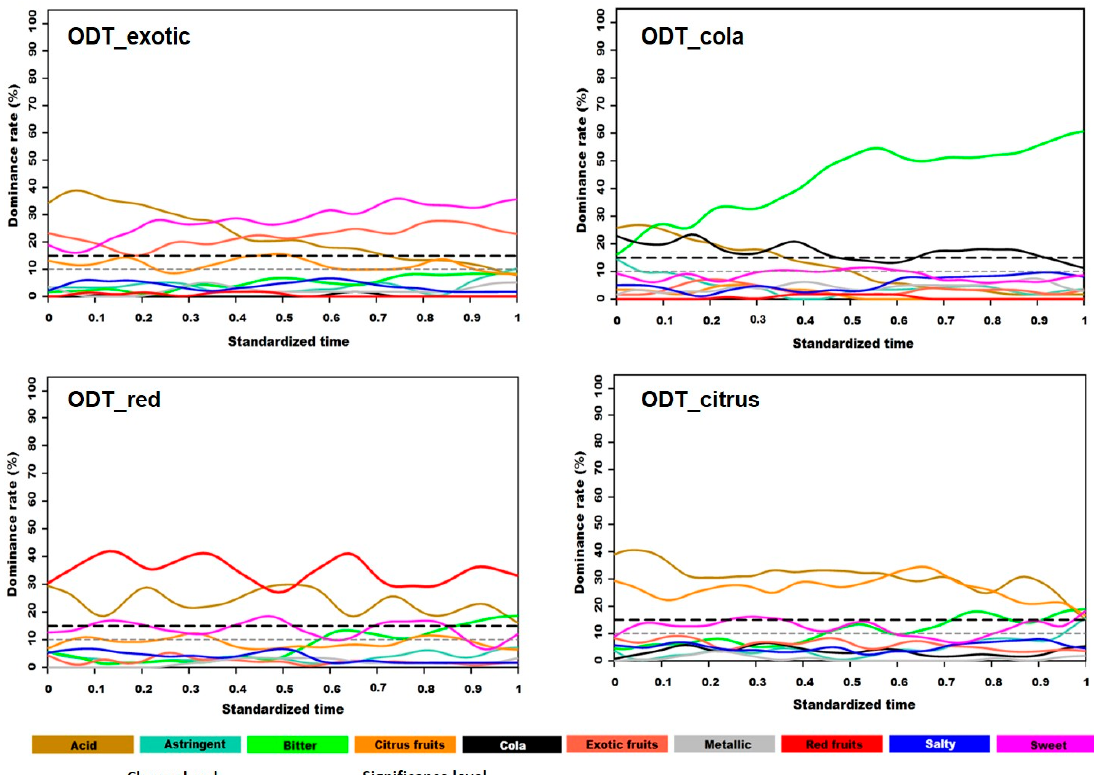
Figure 1. Standardized TDS (Temporal Dominance of Sensations) curves of four ODTs (Orally Disintegrating Tablets).